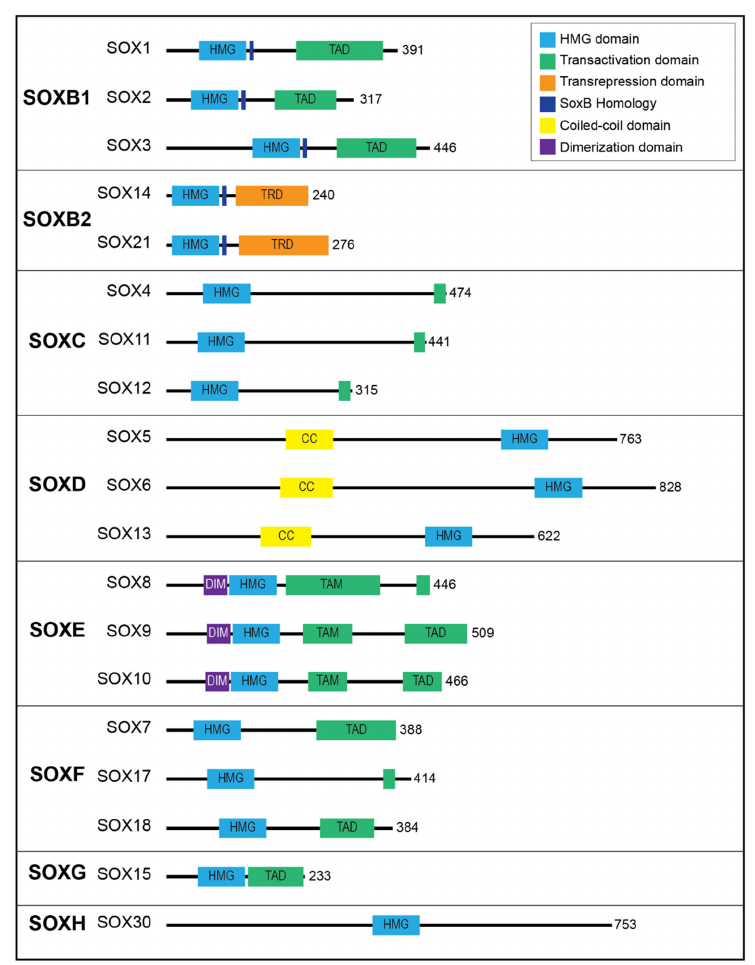
Figure 2. Subfamiles of SOX proteins and the functional domains. The major protein functional domains include the high-mobility group (HMG) domain, transactivation domain (TAD), coiled-coil (CC) domain, transrepression domain (TRD), dimerization (DIM) domain, and SoxB homology domain. Reprinted by permission from Frontiers, Frontiers in Physiology [42], Copyright 2020.